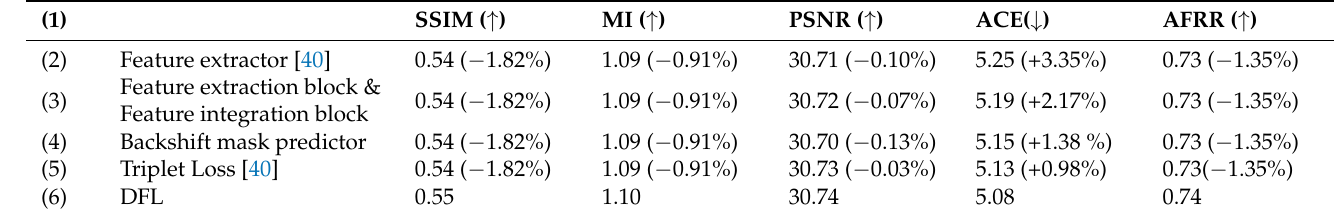
Figure 10. Ablation experiments on the effectiveness of our feature extraction block. Column 1 is the infrared image of our network input. Column 2 is the feature map extracted by [40]. Column 3 is the feature map after replacing the feature extractor in [40] with our feature extraction block and feature integration block. Table 6. Ablation experiments.